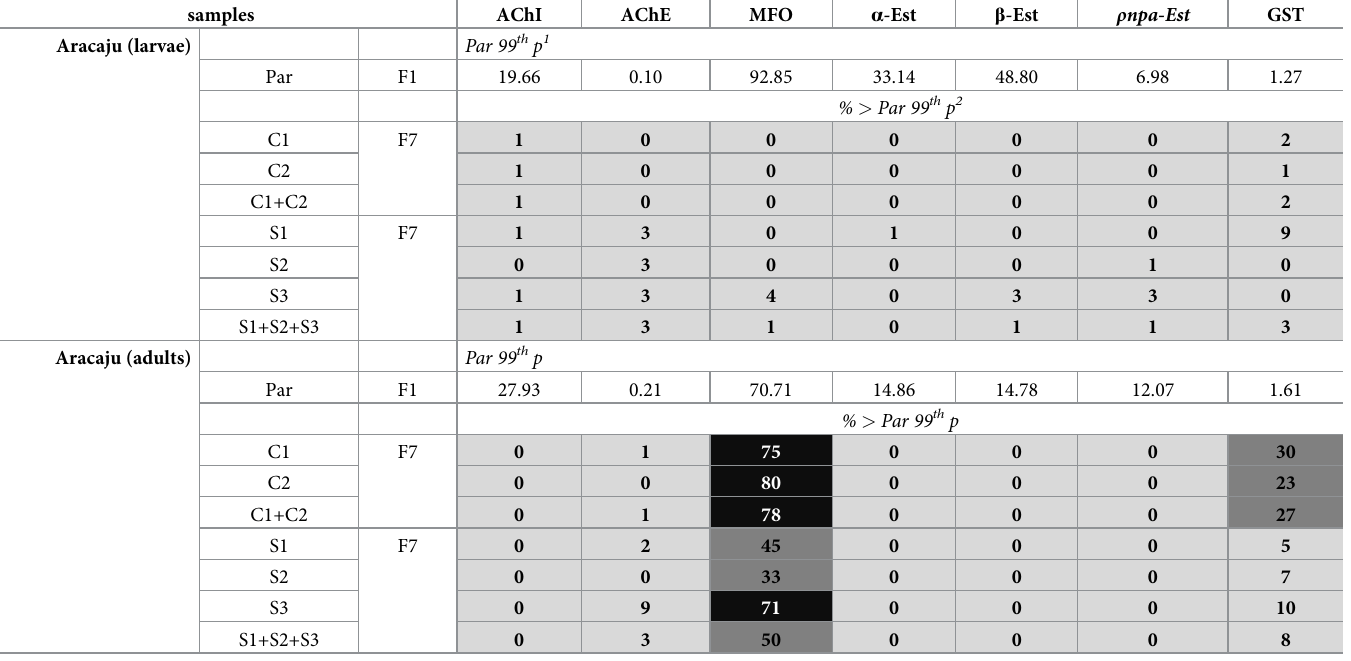
Enzyme activities were classified according to the percentage of individuals with activity above the 99 th percentile of the corresponding parental population [29]: < 15%, between 15 and 50%, and > 50%, being considered normal (in light gray), altered (dark gray), and heavily altered (in black), respectively. All control groups